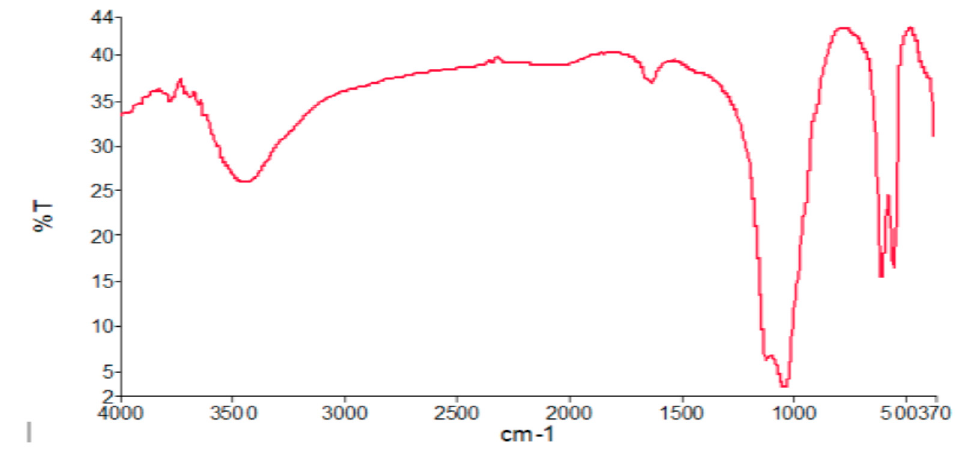
Figure 1. FTIR analysis result of HAP.